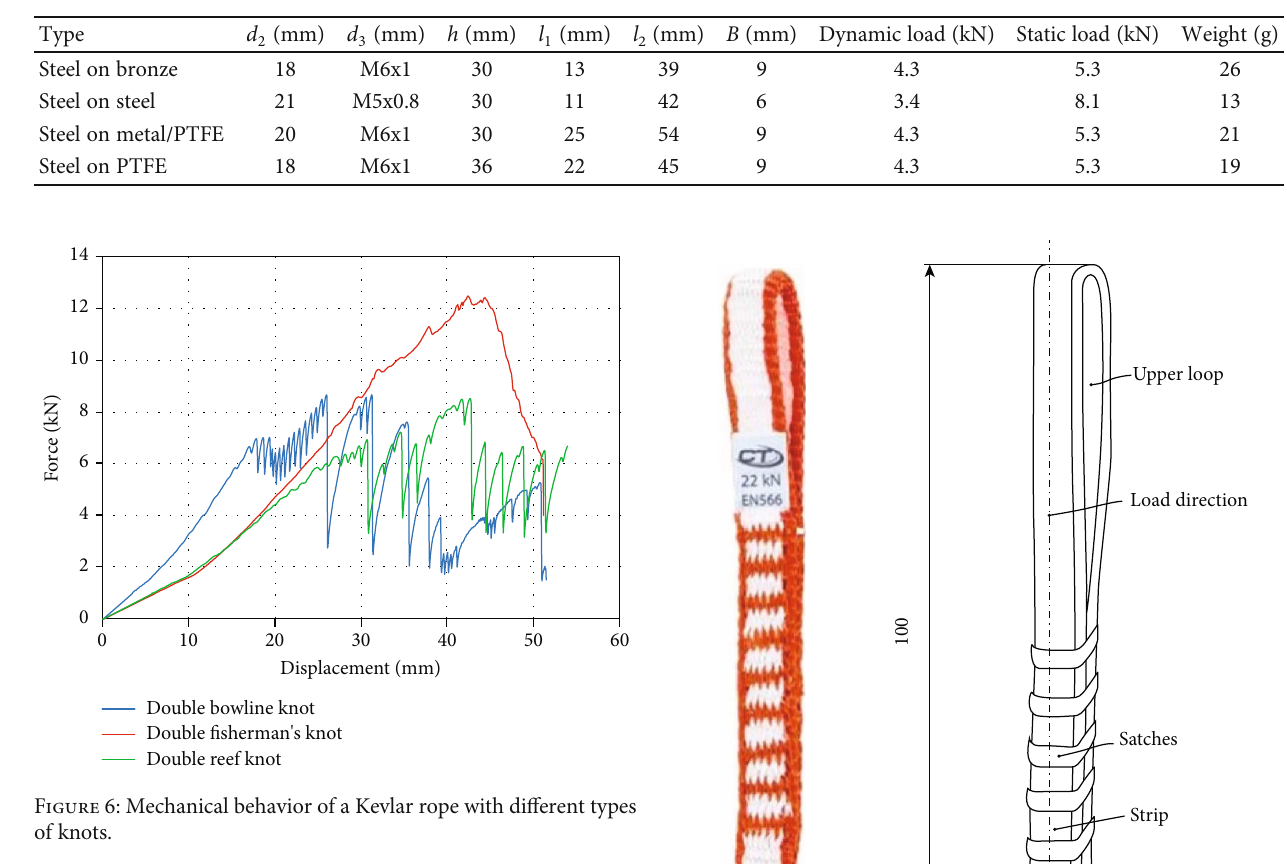
Figure 5: Conventional metal solution. Table 1: Possible commercial spherical